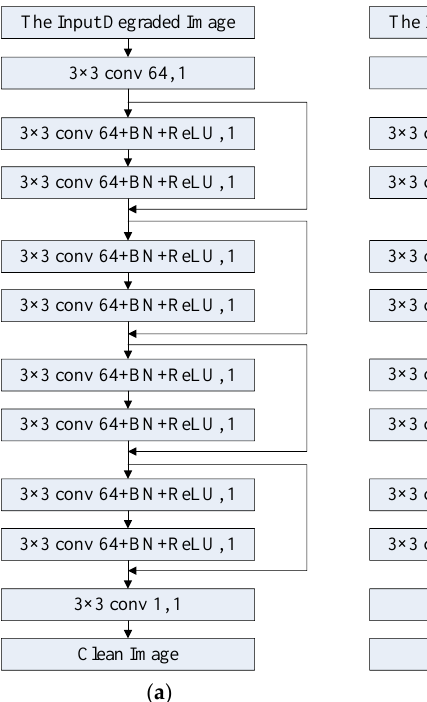
Table 1. Experiment setting of different models.